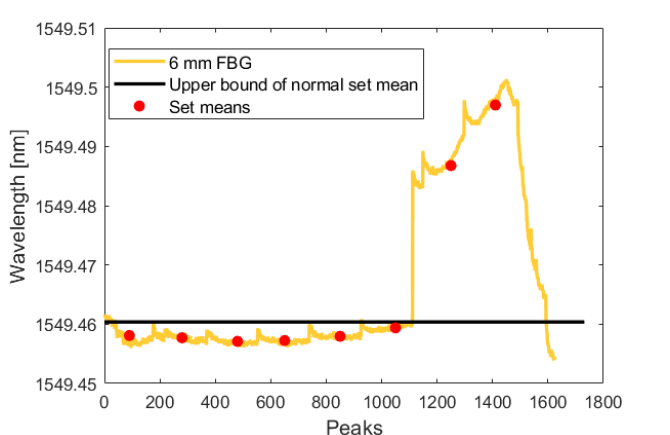
Figure 18. Crack detection analysis during high-amplitude cyclic loading for the FBG embedded 3 mm from the notch tip.